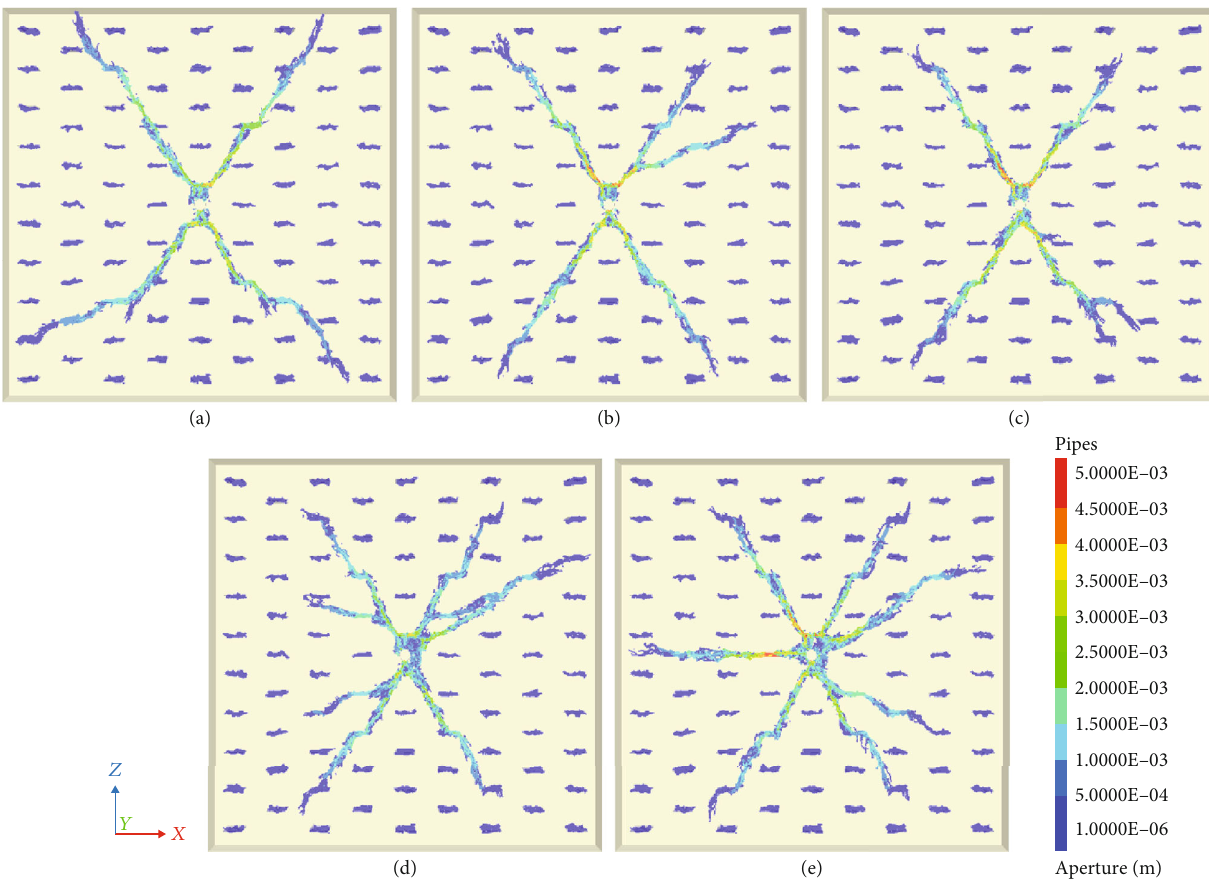
Figure 11: HF propagation in the NFN with injection rates of (a) 0.002m3/s, (b) 0.003m3/s, (c) 0.004m3/s, (d) 0.005m3/s, and (e) 0.007m3/s.